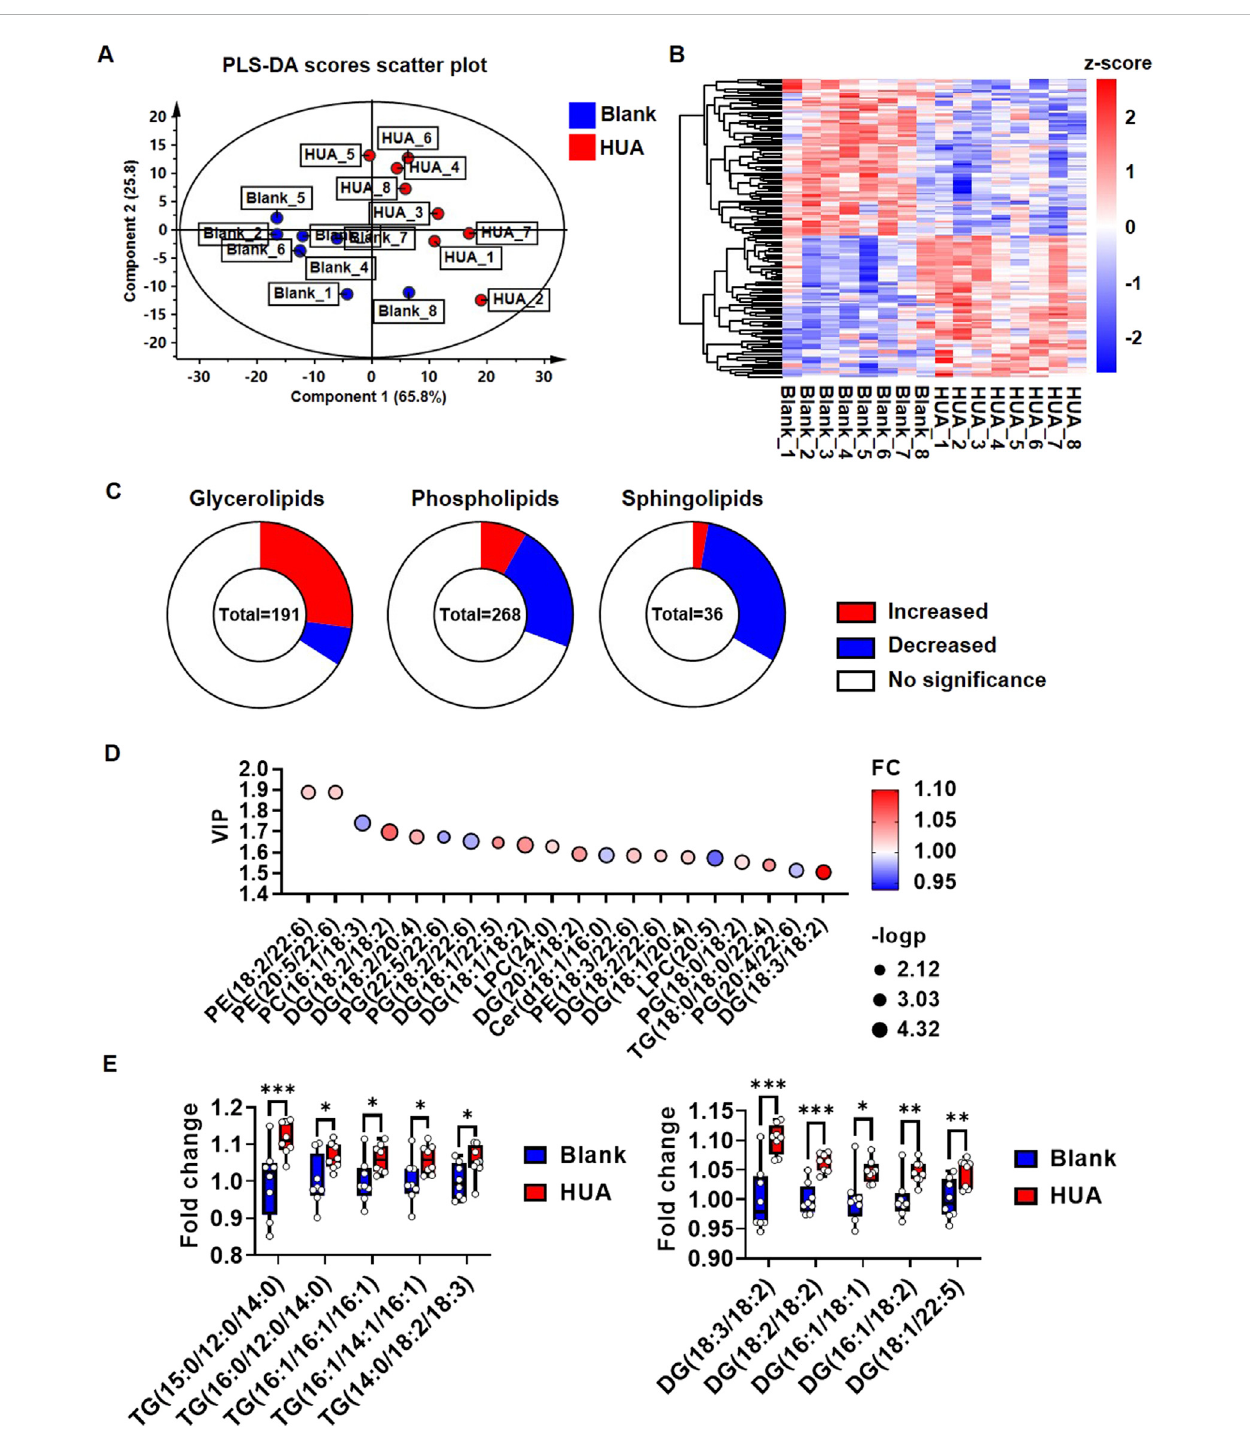
FIGURE 4 Lipidomic pro fi le change of hearts under HUA induction. (A) PLS-DA score scatter plot showing the separation of blank group and HUA group; (B) Heatmap showing the global view of the signi fi cant metabolites of blank and HUA group; (C) Pie chart showing the changes in lipid composition of HUA compare with blank. P < 0.05 was considered as signi fi cance; (D) Bubble plots showing the top 20 signi fi cant metabolites based on VIP values; (E) Box plots showing the top fi ve upregulated TGs and DGs. The results were normalized to the mean value of control ( n = 8).